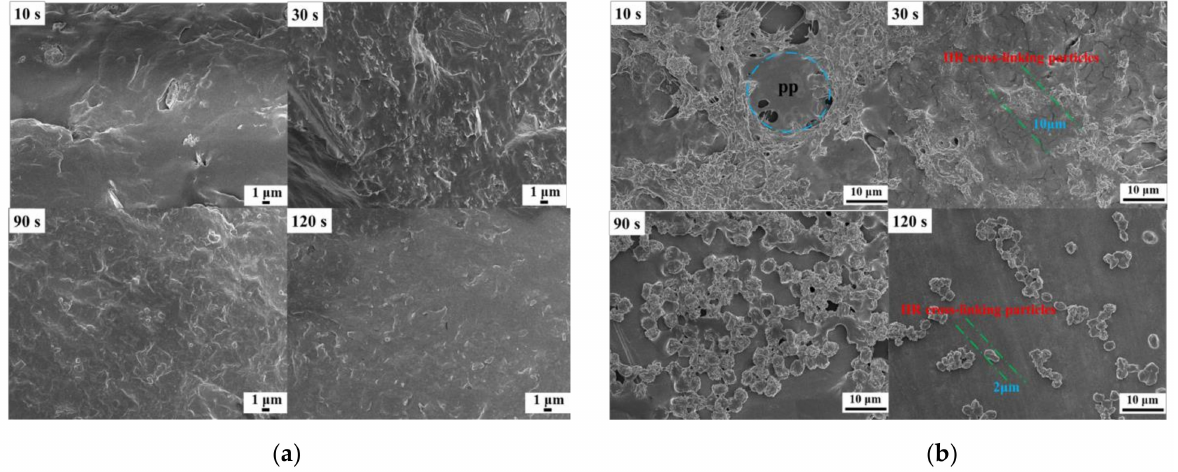
Figure 3. The SEM micrographs: ( a ) IIR/PP-TPV with different DV times; ( b ) cross-linking particles of IIR after samples dissolved in hot xylene (120 ◦ C × 6